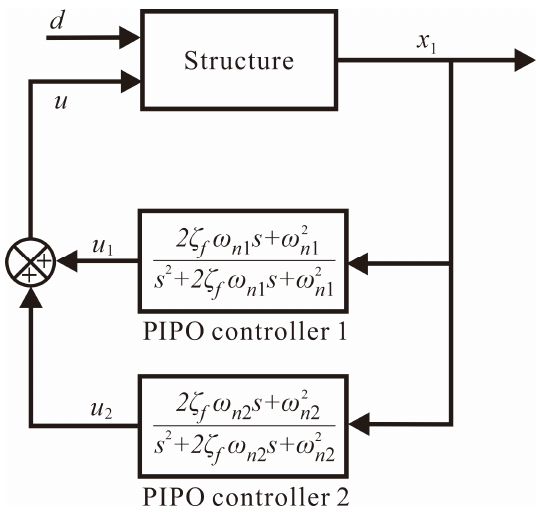
Figure 17. Block diagram for the closed-loop system.